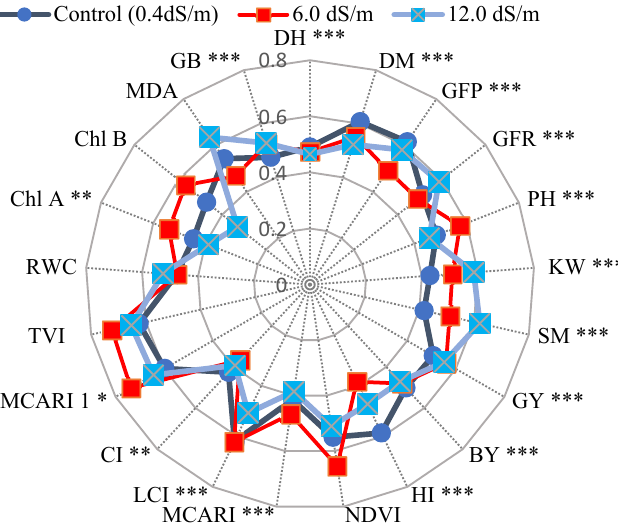
Figure 8. Radar chart for the mean performance of agronomic trait, physiological trait, and spectral reflectance indices (SRI) of ten genotypes evaluated in simulated lysimeter grown under 0.4, 6.0, and 12.0 dS/m diluted seawater in the 2020/21 season. *, ** and *** Significant levels at 0.05, 0.01, 0.001.